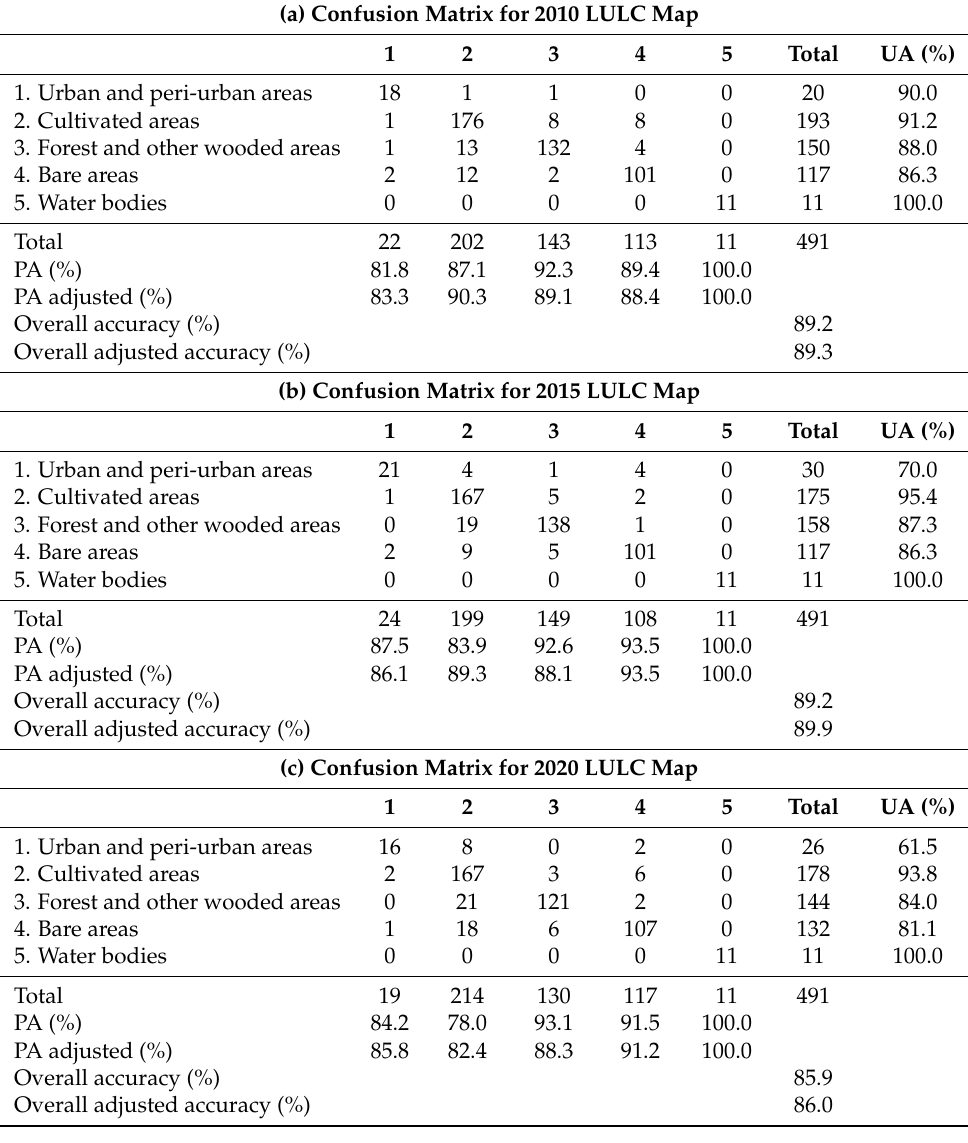
Table 5. Confusion matrices containing the accuracy assessment of the classified LULC categories using a stratified sample for the years 2010, 2015, and 2020. Here, producer’s accuracy is PA and user’s accuracy is